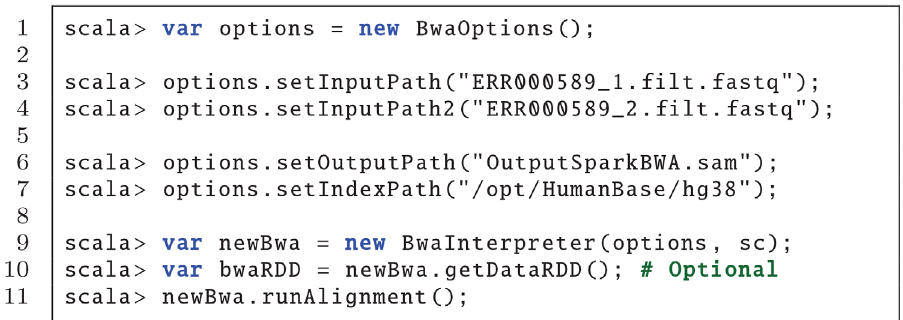
Fig 3. Example running SparkBWA from the Spark Shell (Scala).